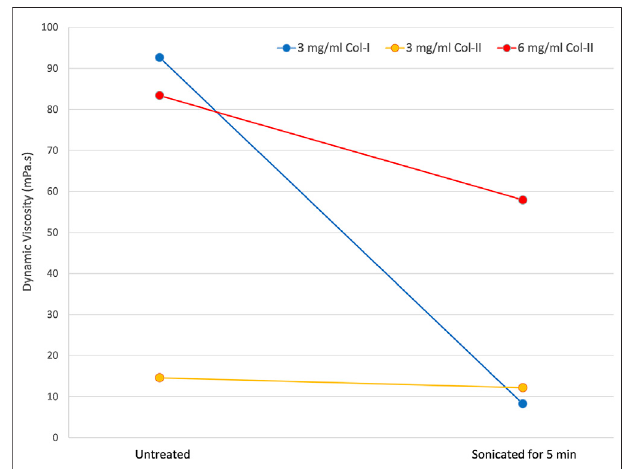
FIGURE 3 | The dynamic viscosity of untreated collagen solutions and thesamesolutionsaftera5-minutetreatmentwithultrasonicatomization inan aerosol jet